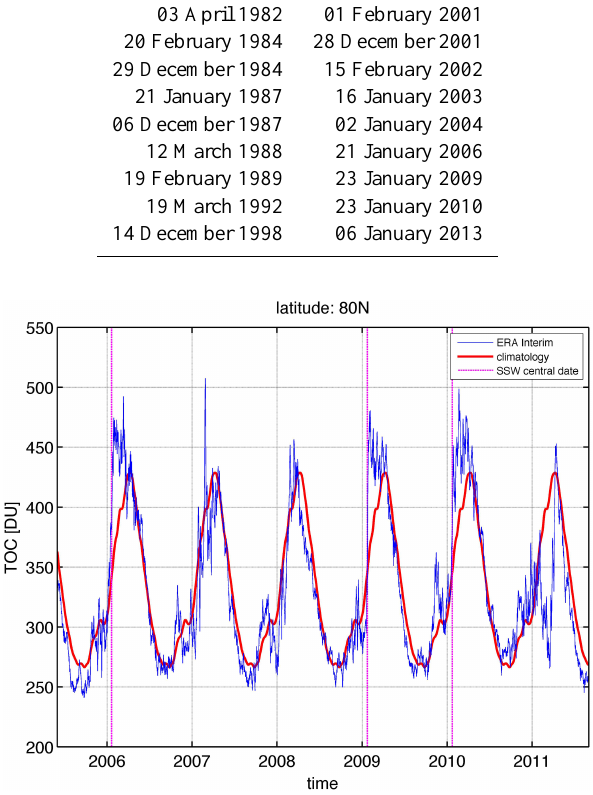
Figure 1. Time series of zonal mean TOC at 80 ◦ N. The blue line is provided by ERA Interim reanalysis. The red line shows the mean seasonal behaviour of TOC as derived from ERA Interim reanalysis data at 80 ◦ N from 1979 to 2014. The vertical, magenta lines denote the central dates of the major SSWs in 2006, 2009 and 2010. Please note the positive anomalies ( > 50DU) of the blue line relative to the red line (climatology) after the onsets of the major SSW events. Xticks are always on 1 January.